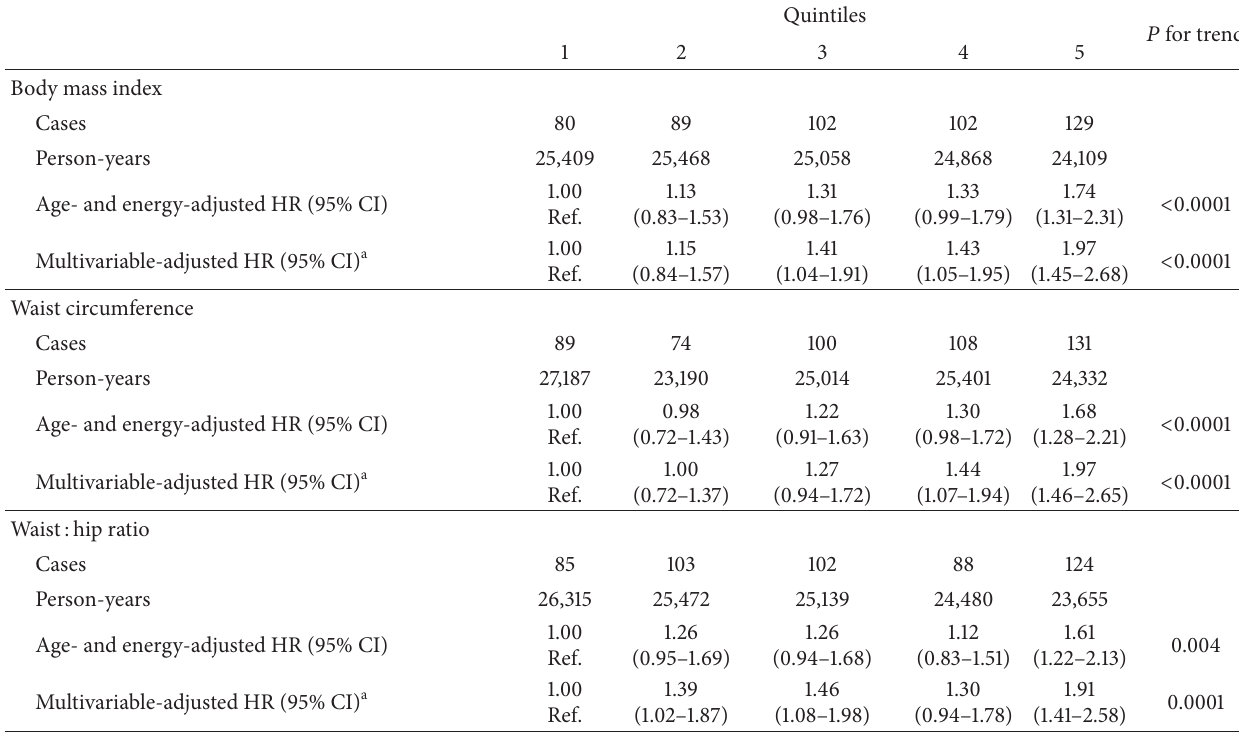
Table 4: Hazard ratios (HR) and 95% confidence intervals (CI) for the association of body mass index, waist circumference, and waist-hip ratio with risk of incident, invasive breast cancer in postmenopausal